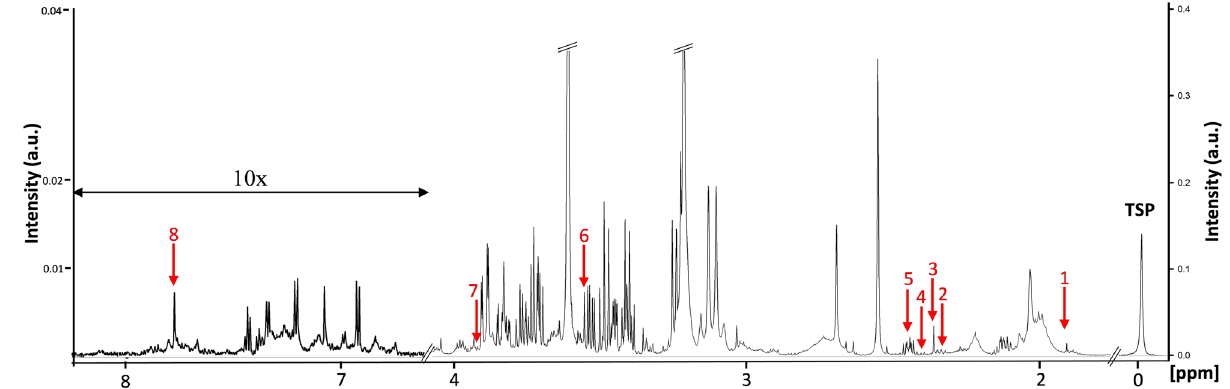
Figure 2. Representative 600 MHz 1 H-NMR spectra of plasma showing the selected eight metabolite signals (δ1–9). x axis, parts per million (ppm); y axis, intensity (a.u.). 1, Acetic acid; 2, Proline; 3, Pyruvic acid; 4, Succinic acid; 5, Glutamine; 6, Glycine; 7, Creatine; 8,